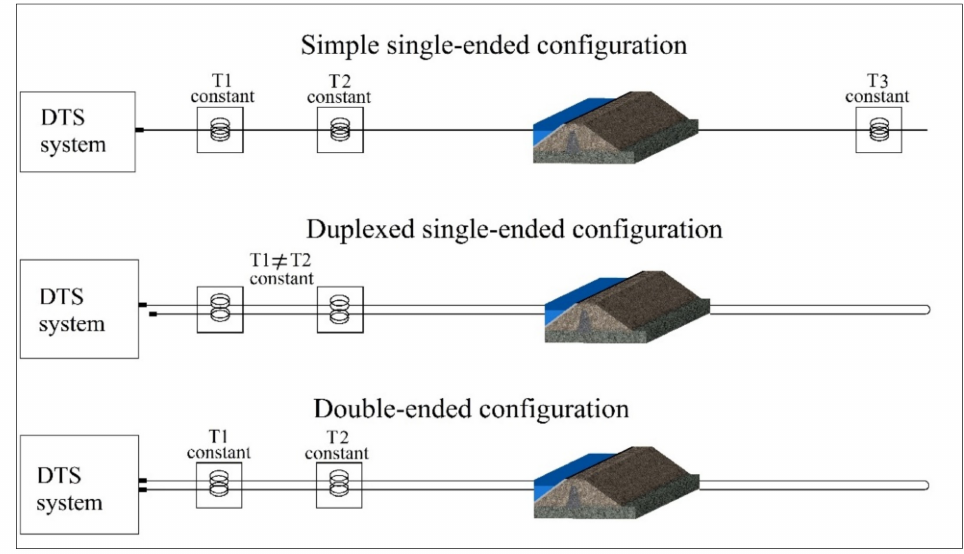
Figure 1. Optical fiber installation configurations for manual calibration